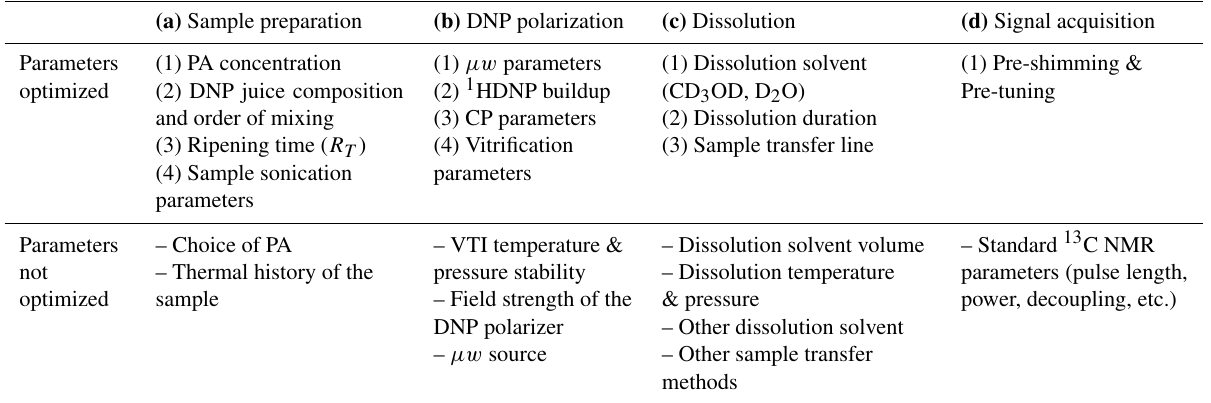
Table 1. List of parameters for the plan of optimization of DNP setting. PA: polarizing agent. CP: cross-polarization. µw : microwaves. VTI: variable temperature insert (enclosure where the sample is vitrified, hyperpolarized, and dissolved at cryogenic